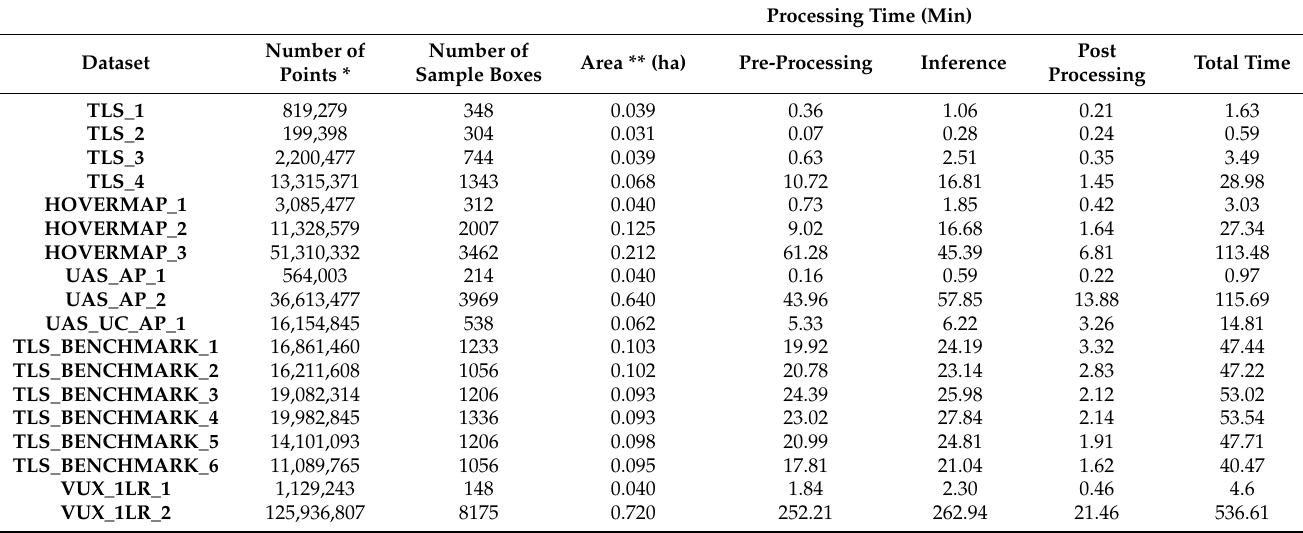
Table 6. Processing times of our method with respect to the number of points (after subsampling to 0.01 m minimum distance) between